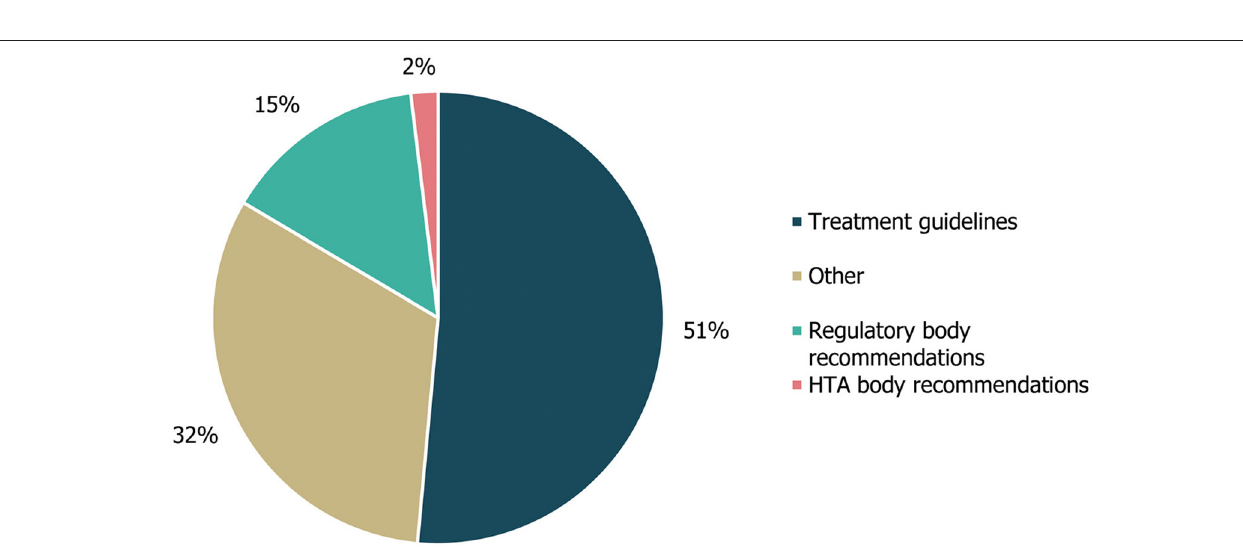
FIGURE 5 | Guideline cross-referencing to other treatment guidelines and regulatory/HTA recommendations. Cross-referencing refers to the number of different treatment guidelines, regulatory body recommendations, HTA body recommendations or other references that were cited within the guidelines identified in this study, either in the body of the guideline text or in accompanying reference lists. “Other” references included a Cochrane systematic literature review, an information website, a narrative review and a consensus conference report. HTA, health technology